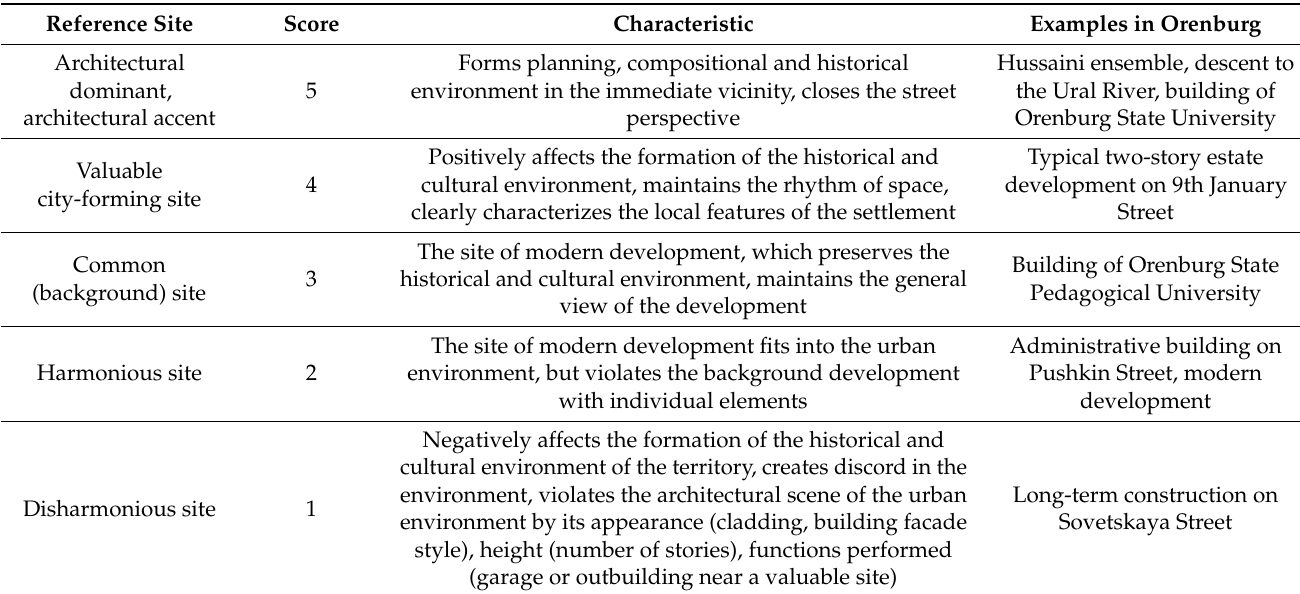
Table 1. Scoring scale of urban planning